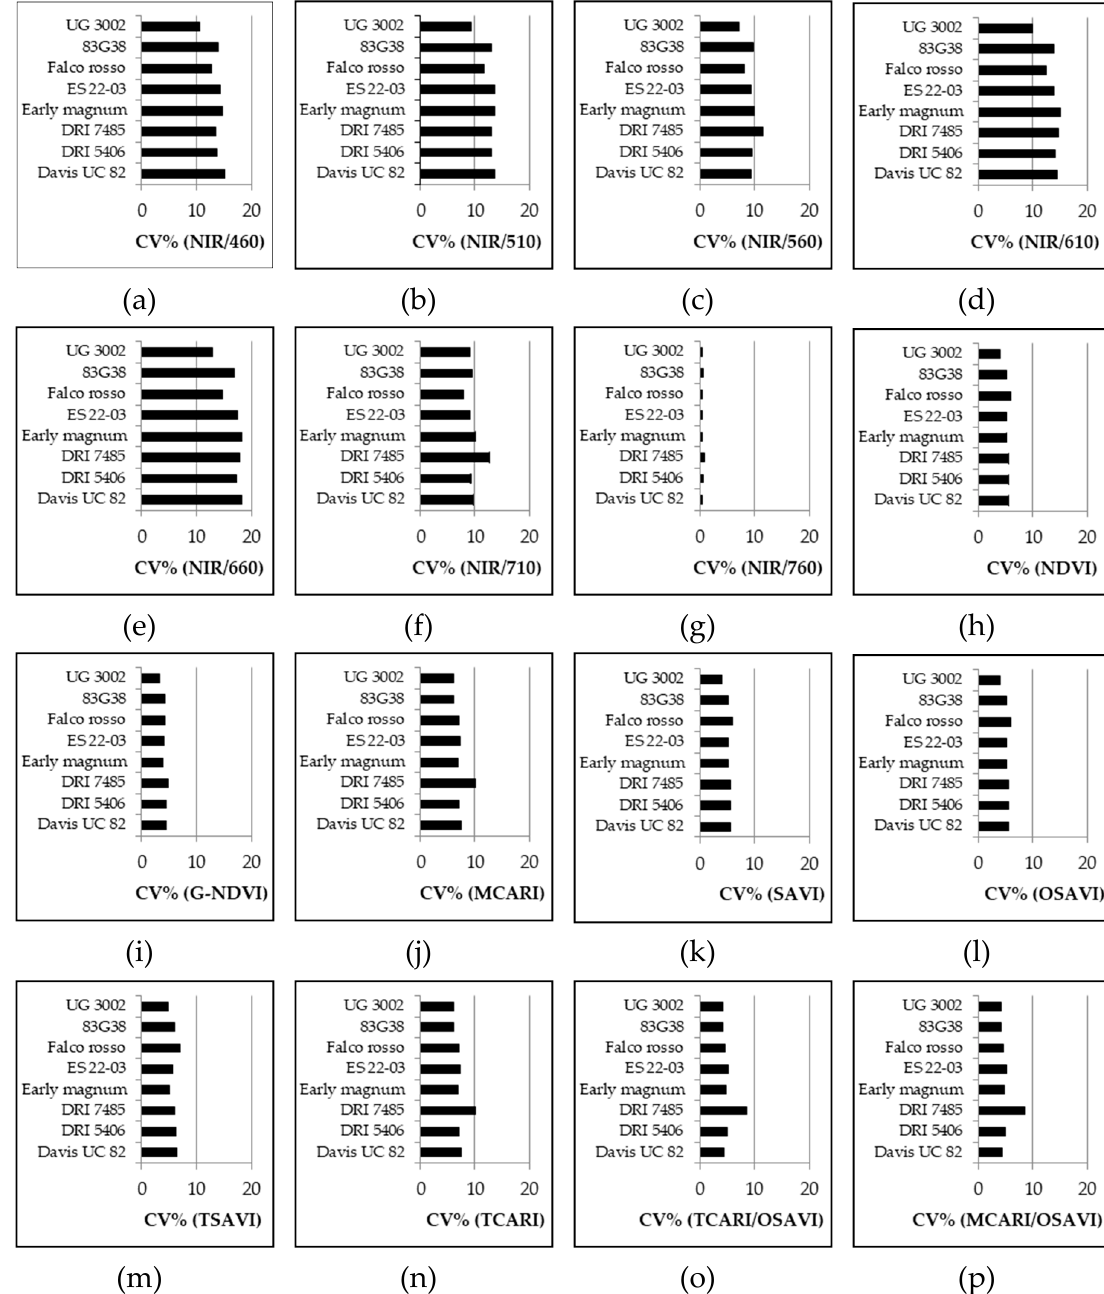
Figure 5. Experiment 5#. Coefficient of variation (CV%) of different VIs for different varieties, generated with bootstrap analysis by using SET VARIETY (see Section 2.3 data analysis).